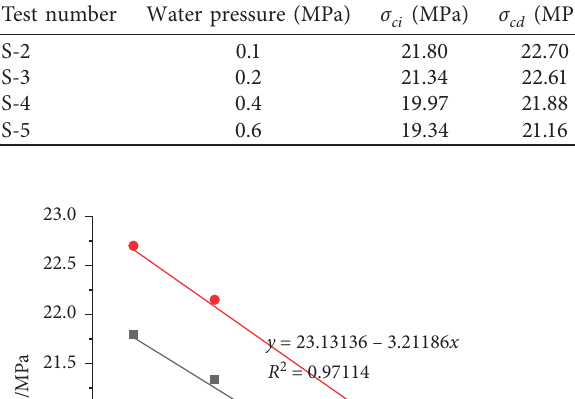
Table 3: Strength characteristic values of unloading seepage. Test number